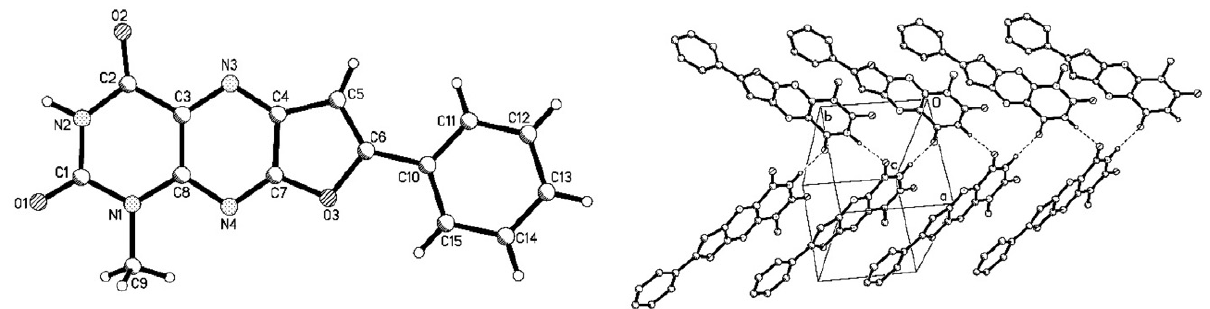
Fig. 1. Molecular structure and packing of molecules in a crystal of compound 2a